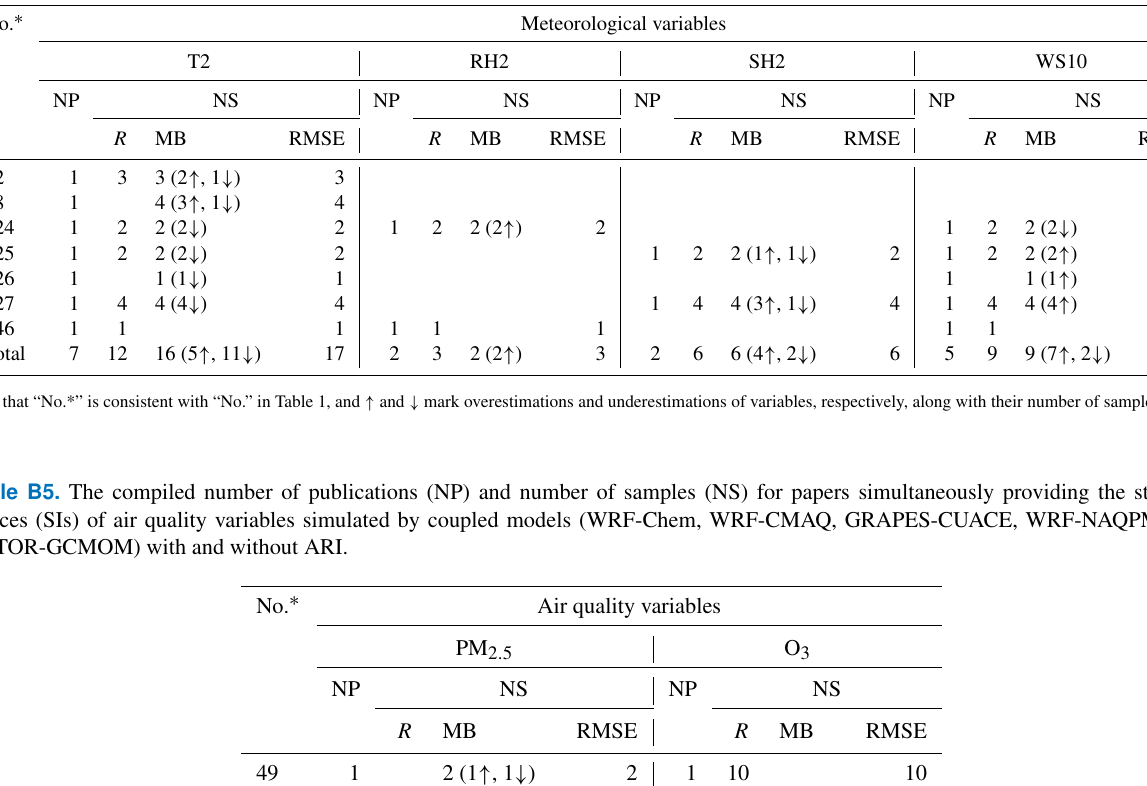
Table B4. The compiled number of publications (NP) and number of samples (NS) for papers simultaneously providing the statistical indices (SIs) of meteorological variables simulated by coupled models (WRF-Chem, WRF-CMAQ, GRAPES-CUACE, WRF-NAQPMS, and GATOR-GCMOM) with and without ARI.